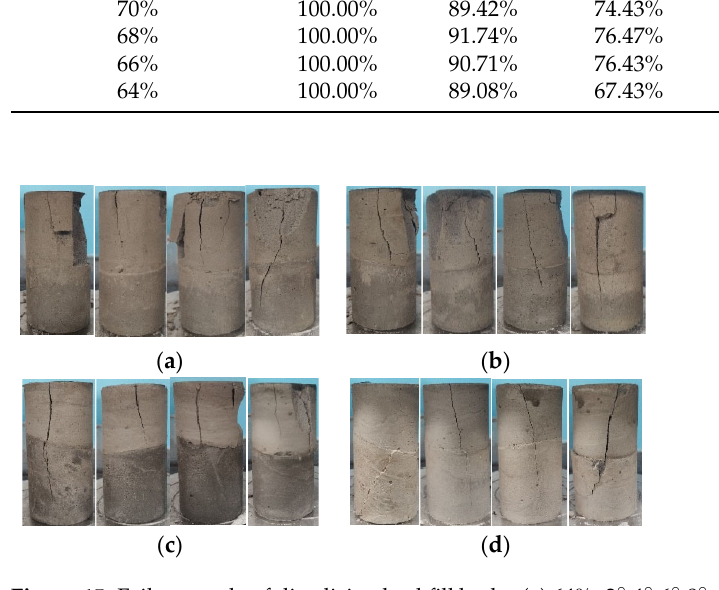
Figure 15. Failure mode of dip slicing backfill body: ( a ) 64%: 2° 4° 6° 8°; ( b ) 66%: 2° 4° 6° 8°; ( c ) 68% 2° 4° 6° 8°; ( d ) 70% 2° 4° 6° 8°.